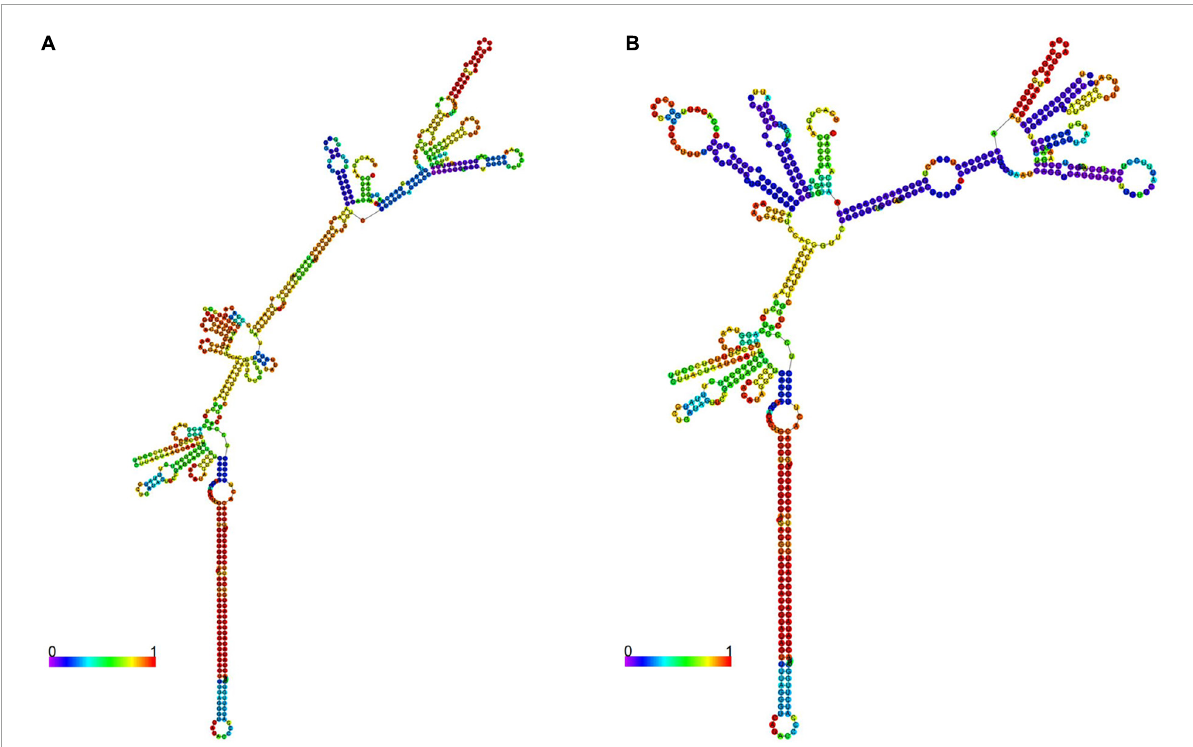
FIGURE2 The pri-let-7f-2 mRNA secondary structures. Two 601-nt long pri-let-7f-2 DNA sequences centered on the rs17276588 polymorphism were inserted into the rs17276588- G (A) and rs17276588- A allele (B) RNA fold. The minimum free values (MAF) and figures were obtained from the RNA fold online tool